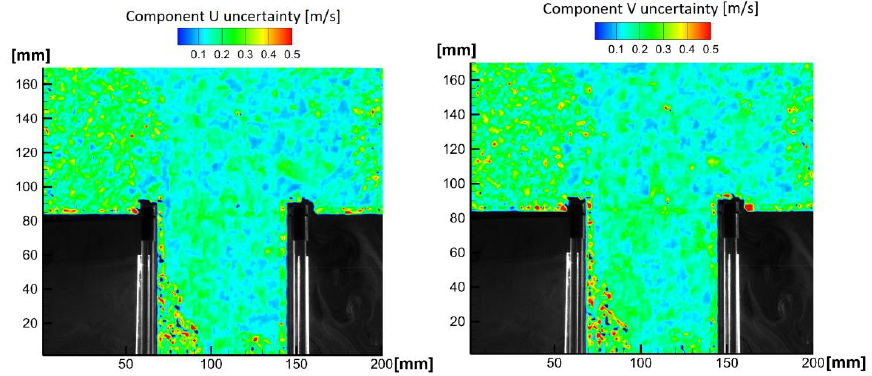
Figure 6 . Uncertainty maps for the velocity vector components U ( left ) and V ( right ).